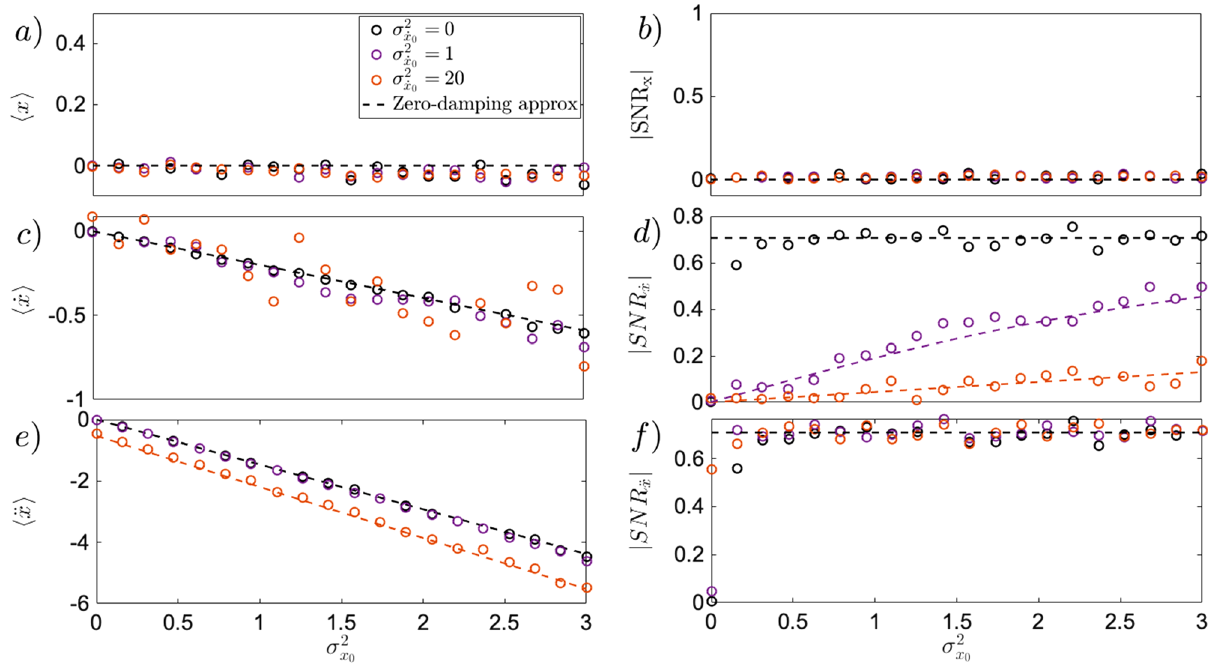
Figure 4. Robustness of initial uncertainty-induced effect to initial velocity uncertainty σ 2 statistics (a,b) , instantaneous velocity statistics (c,d) , and instantaneous acceleration (e,f) . All simulations (dots) have been performed based on Eq. (1) using increasing initial velocity uncertainty σ 2 (b) . In the middle panel, for instantaneous velocity, the uncertainty-induced feature is still observable